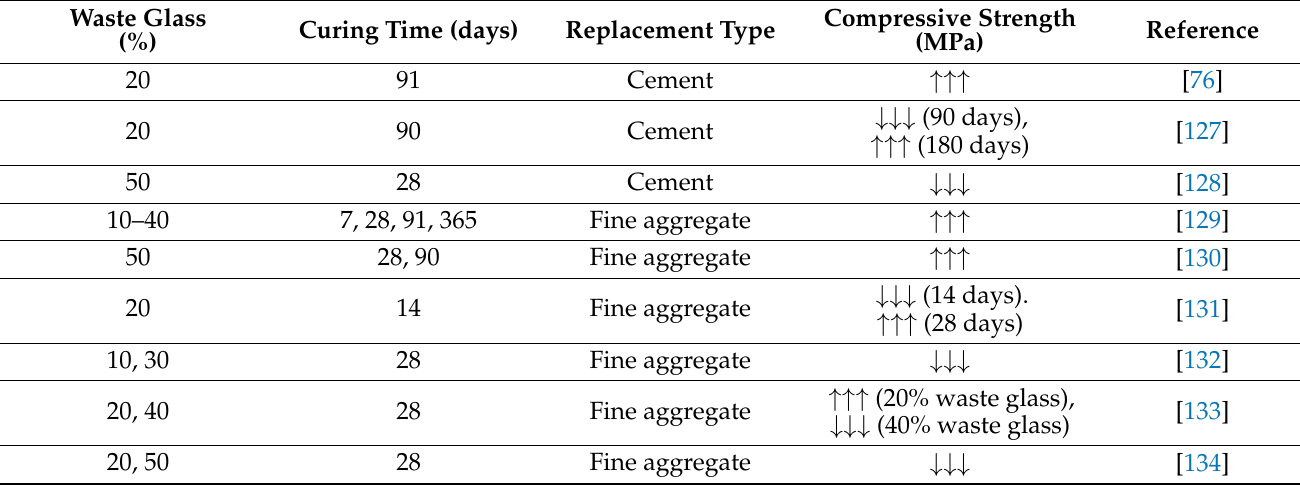
Table 1. Effect of waste glass on compressive